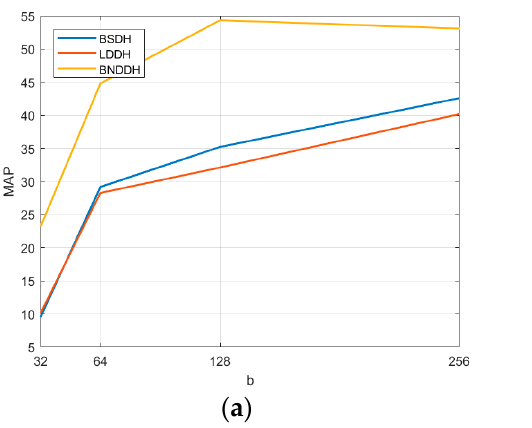
Figure 8. Training time on the MNIST database. ( a ) training time ( b ) testing time.